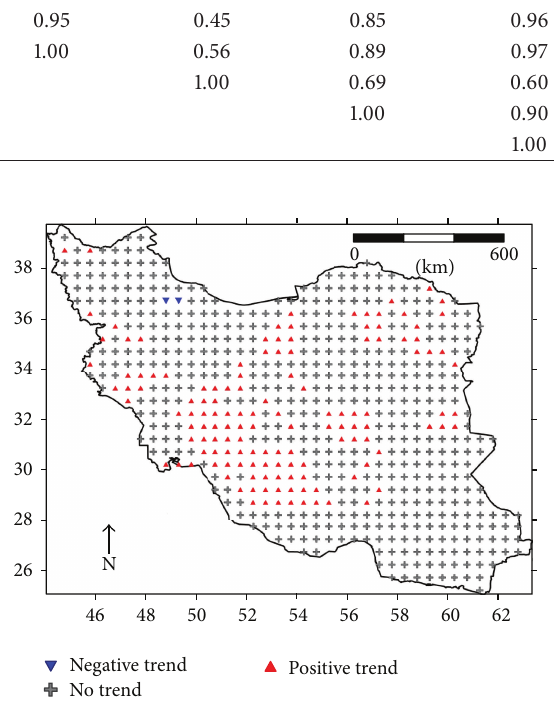
Figure 7: Results from Mann-Kendall Rank Statistic showing the significance of trends ( 𝑝 = 0.01 ) in the number of days with precipitation ≥ 10